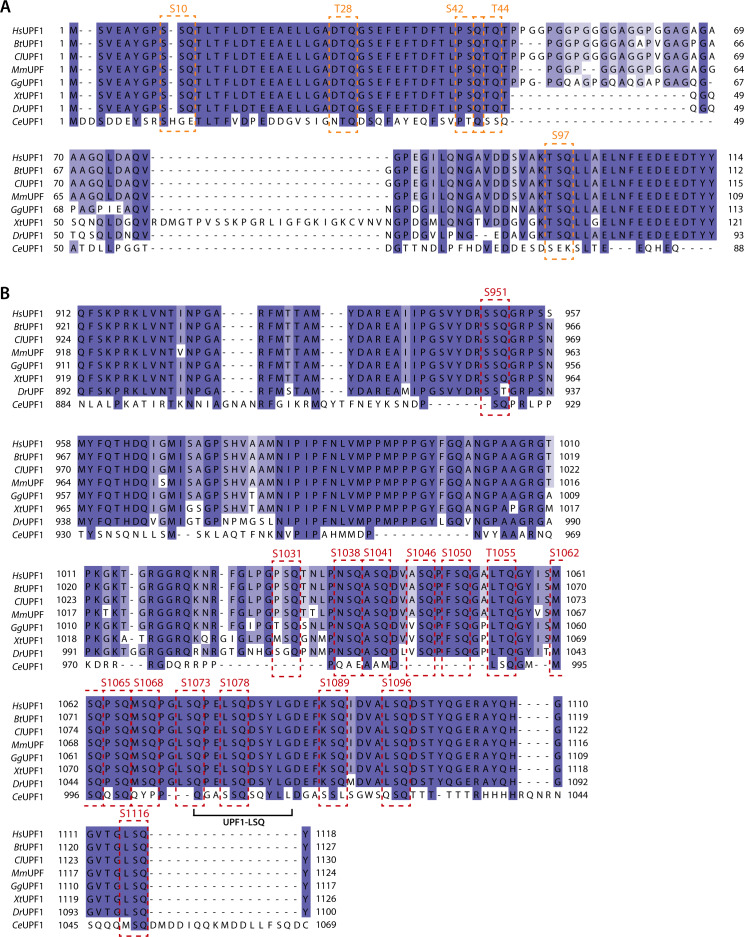
Alignment of UPF1 N- and C-terminal sequences from Homo sapiens, Bos taurus, Canis lupus, Mus musculus, Gallus gallus, Xenopus tropicalis, Danio rerio and Caenorhabditis elegans.The alignment is colored according to conservation. (A) Sequence alignment of UPF1 N-terminus. SQ motifs are highlighted by orange boxes with the phosphorylation site position indicated on top. (B) As in A, but for UPF1 C-terminus and using red color to indicate SQ motifs. Location and range of UPF1-LSQ are indicated.